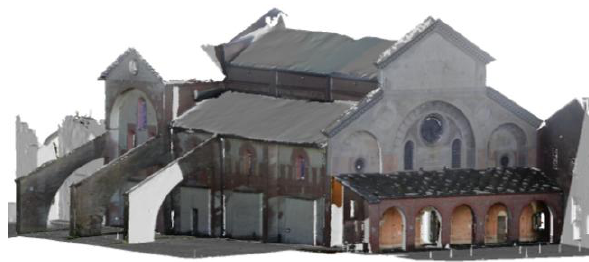
Figure 5. Final textured